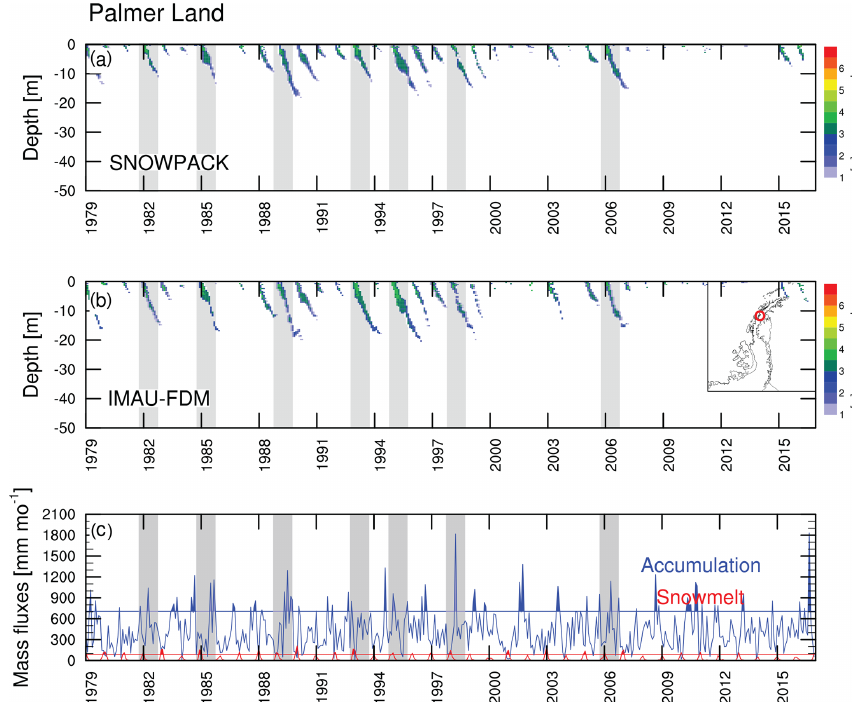
Figure 12. As for Fig. 9 but for a location in Palmer Land (see inset and Fig. 5).